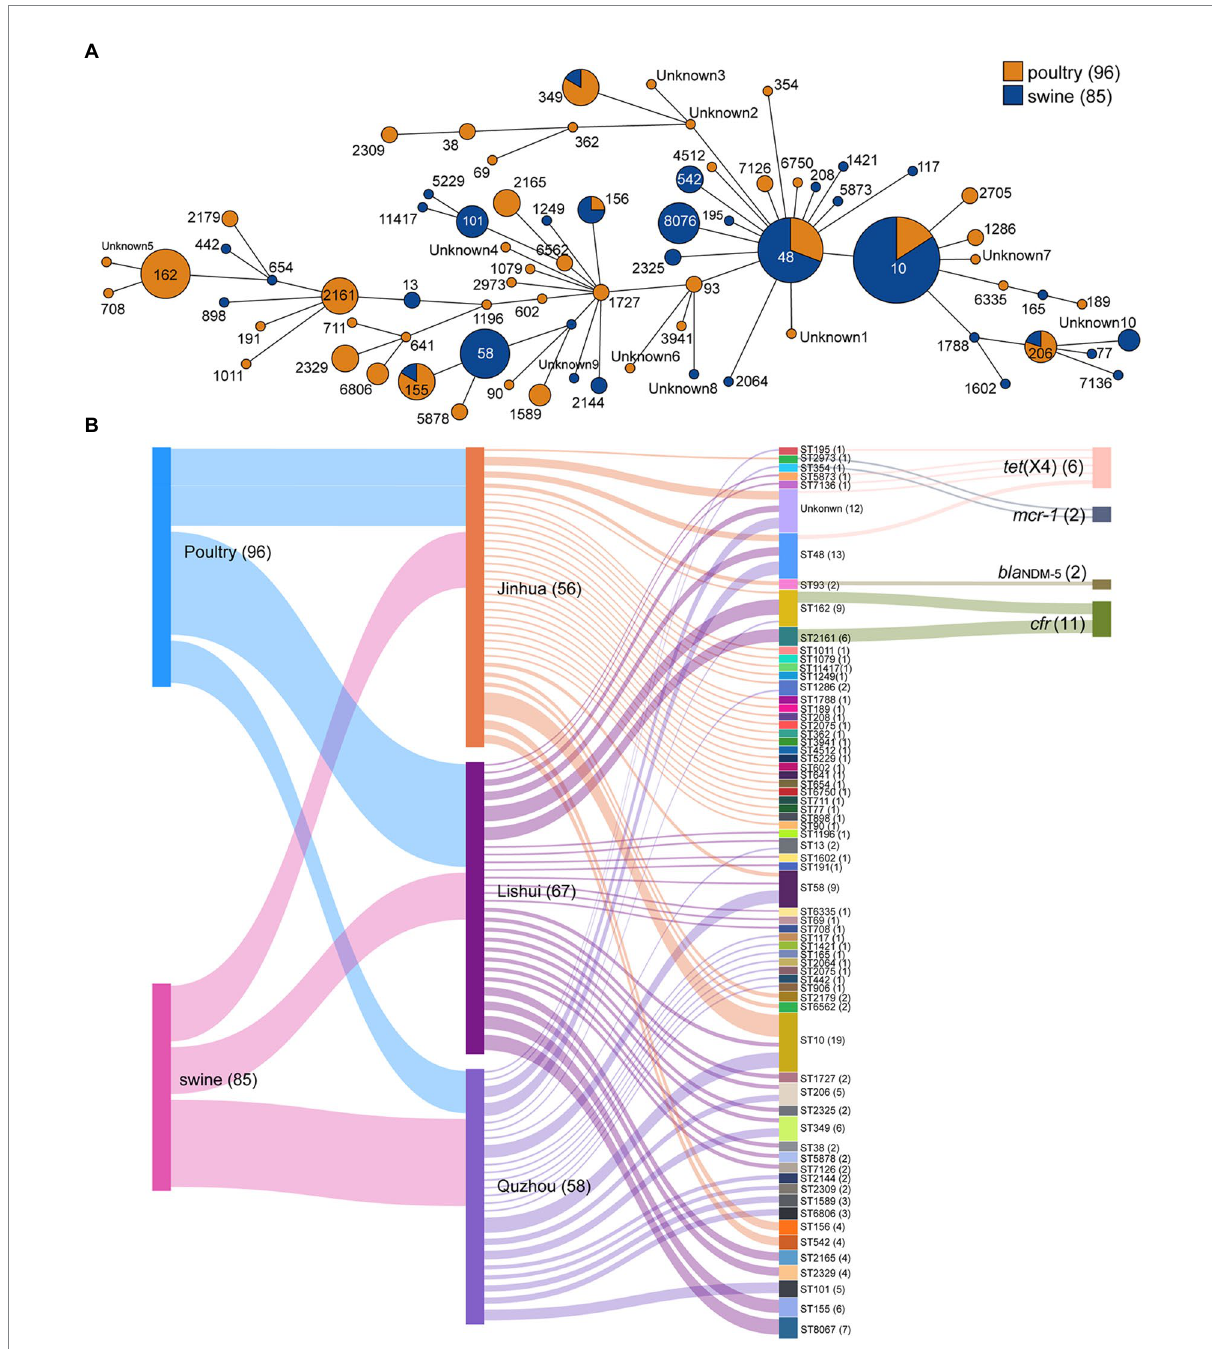
FIGURE 3 Minimum spanning tree of E. coli strains based on MLST and Sankey diagram combining the provinces, STs, farms, and sampling sources based on 181 E. coli isolates. (A) Each node represents a single ST. The size of the nodes is proportional to the number of isolates. The length of branches between each node is proportional to the number of different alleles that differ between two linked nodes; (B) the diameter of the line is directly proportional to the number of isolates, which is also marked with numbers. The lines are colored according to the city and the sampling